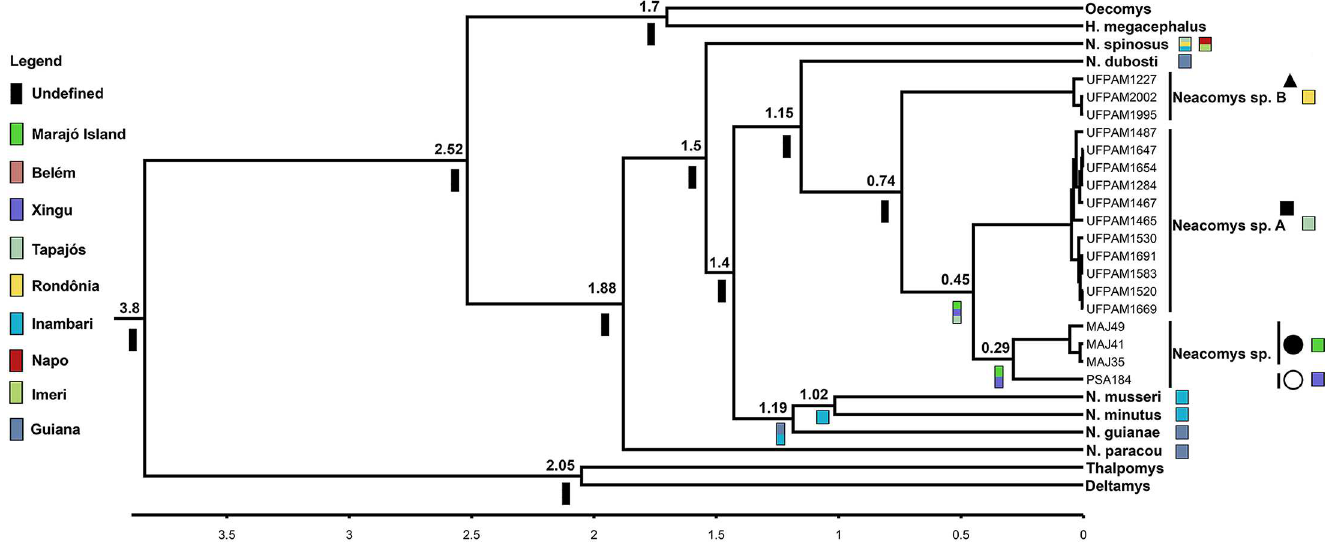
Fig 7. Chronogram derived from a Bayesiananalysis of the concatenated mitochondrial genes (COI and Cytb) of Neacomys genus. The scale shows divergencetimes as millions of years ago (Ma). Coloredbars correspond to ancestralareas recovered by Vicariance-Dispersionanalysis, to Marajo´ islandand Amazon endemicareas mentioned in Fig 1. The symbols refer to species mentioned in Fig 1. Legend:black square ( Neacomys sp. A), black triangle( Neacomys sp. B), white circle ( Neacomys sp. from Maraba´) and black circle ( Neacomys sp. from Marajo´ island) [28].